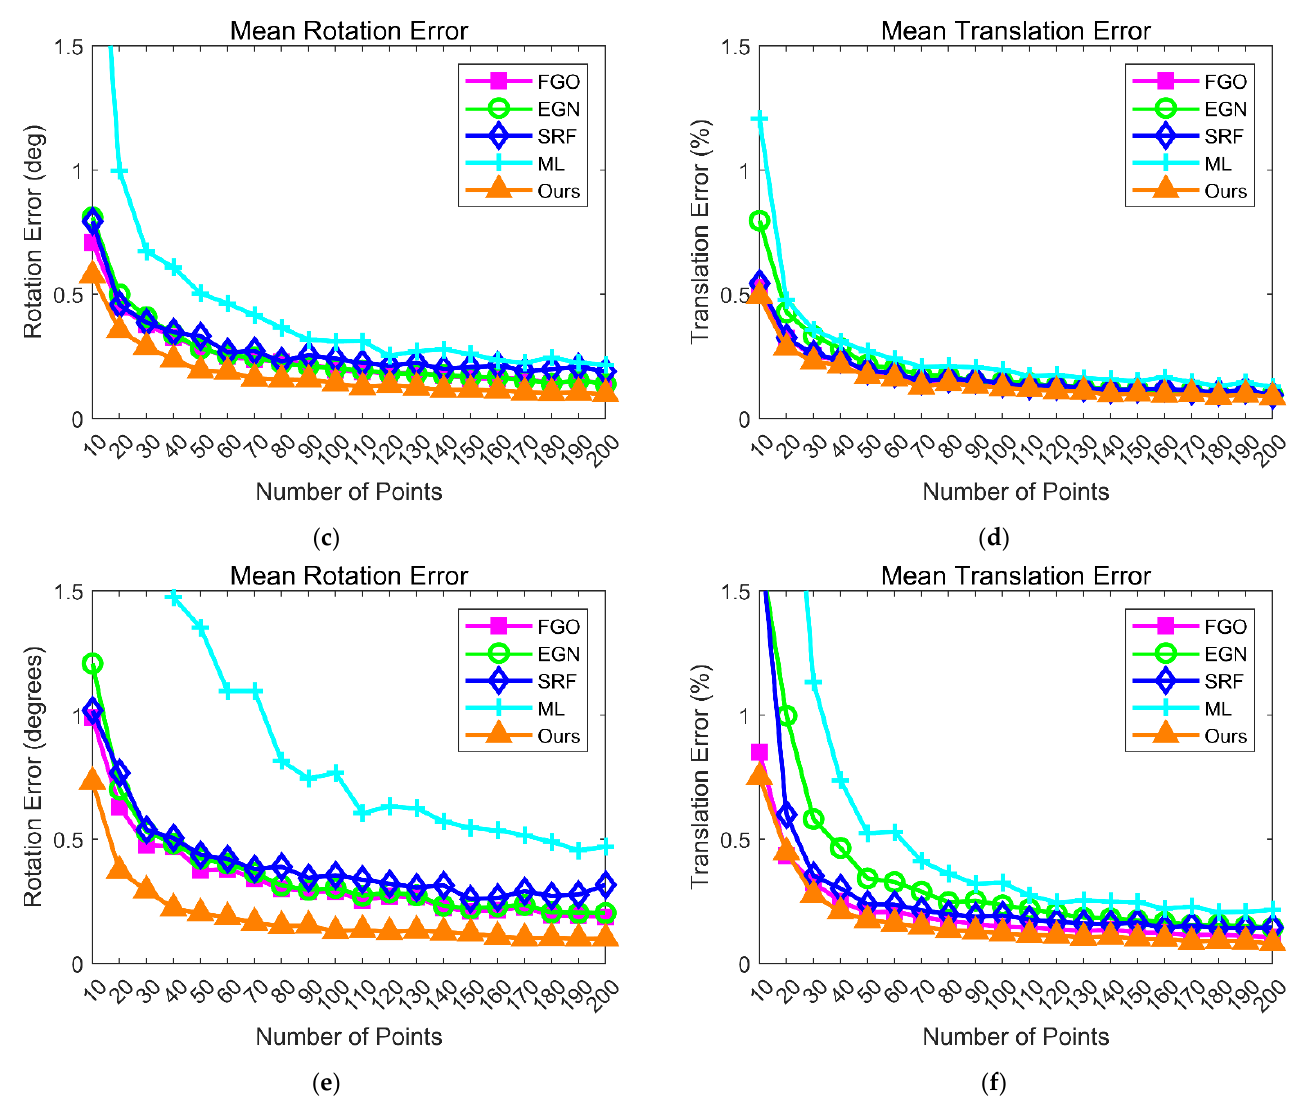
Figure 3. The accuracies of pose determinations with respect to the number of reference points. ( a , b ) are in the planar configuration; ( c , d ) are in the ordinary configuration; and ( e , f ) are in the quasi-singular configuration, respectively.